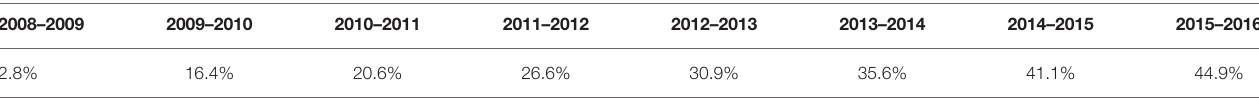
TABLE 4 | Kevin Love proportion of three-point shotting, 2008–2009 to